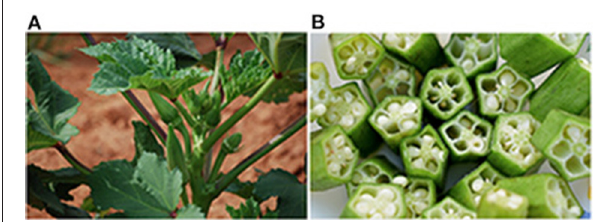
FIGURE 10 | African okra (Abelmoschus callei). (A) Okra plant at the podding stage. Source: M. Shelton. CC BY-NC 2.0. (B) Sliced okra pods prepared for cooking. Source: S.